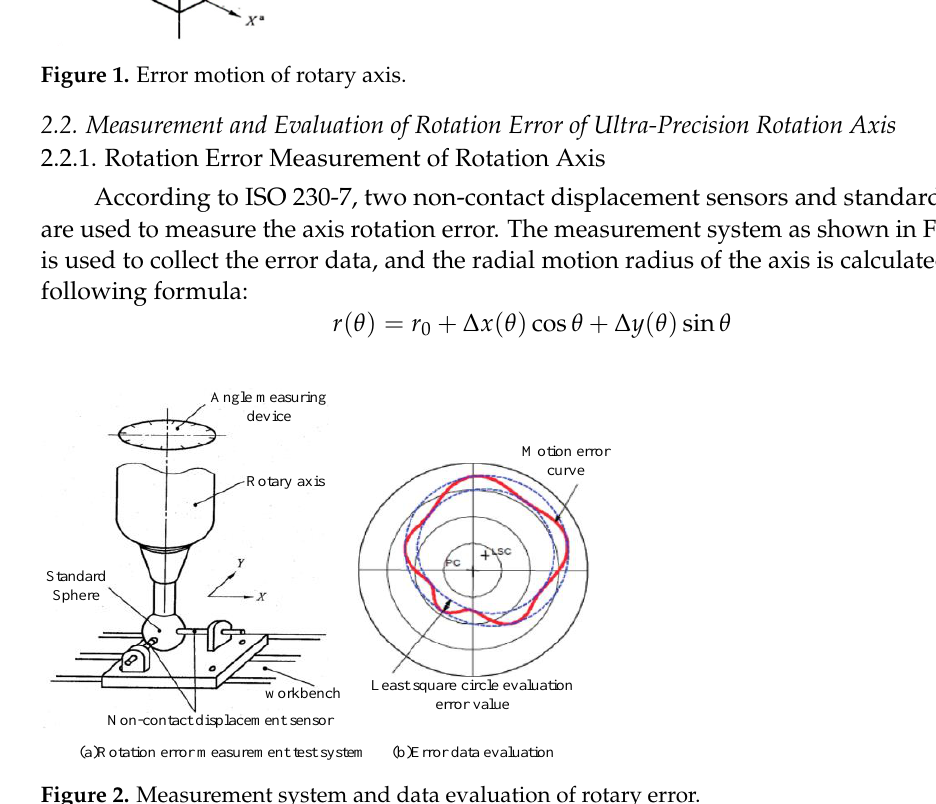
Figure 1. Error motion of rotary axis.